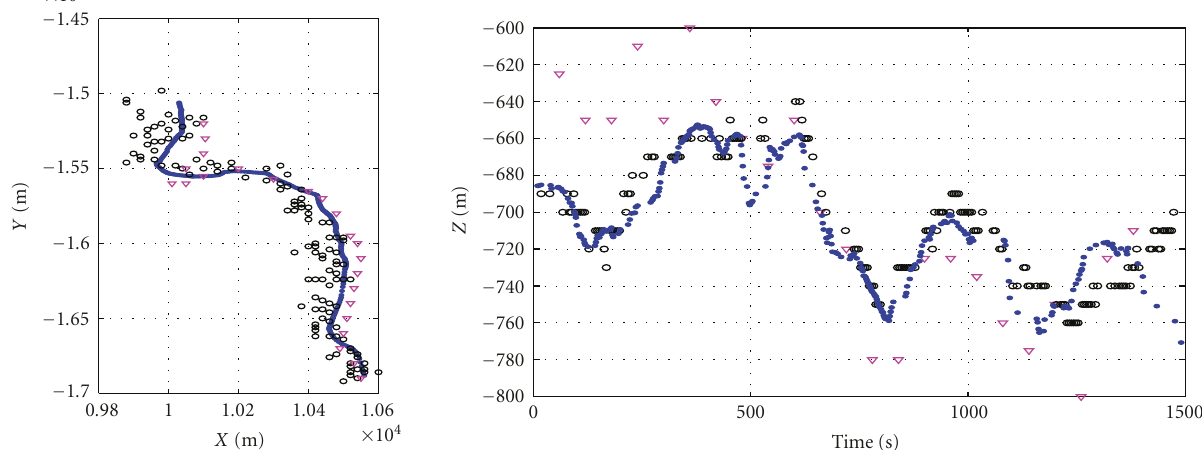
Figure 3: Plan view and diving profile of the marine mammal in dataset 2, estimates with a constant profile, and the SMF method ( · ); and estimates from Morrissey’s ( ∇ ) and from Nosal’s methods (o).